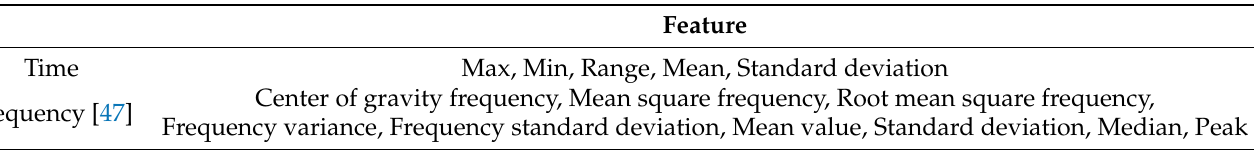
Table 1. Time-domain and frequency-domain features extracted from each